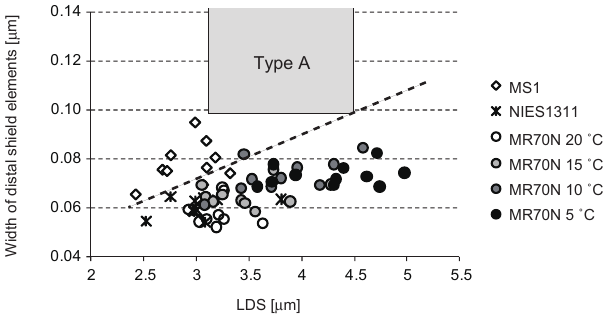
Figure 4. Relationship between the width of the distal shield el- ements and LDS in E. huxleyi strain MR70N grown at 5, 10, 15, and 20 ◦ C and strains MS1 and NIES1311 grown at 20 ◦ C. Area de- scribed with Type A indicates an area where sizes of Type A coccol- iths distribute in the literature (Young and Westbroek, 1991; Cook et al.,